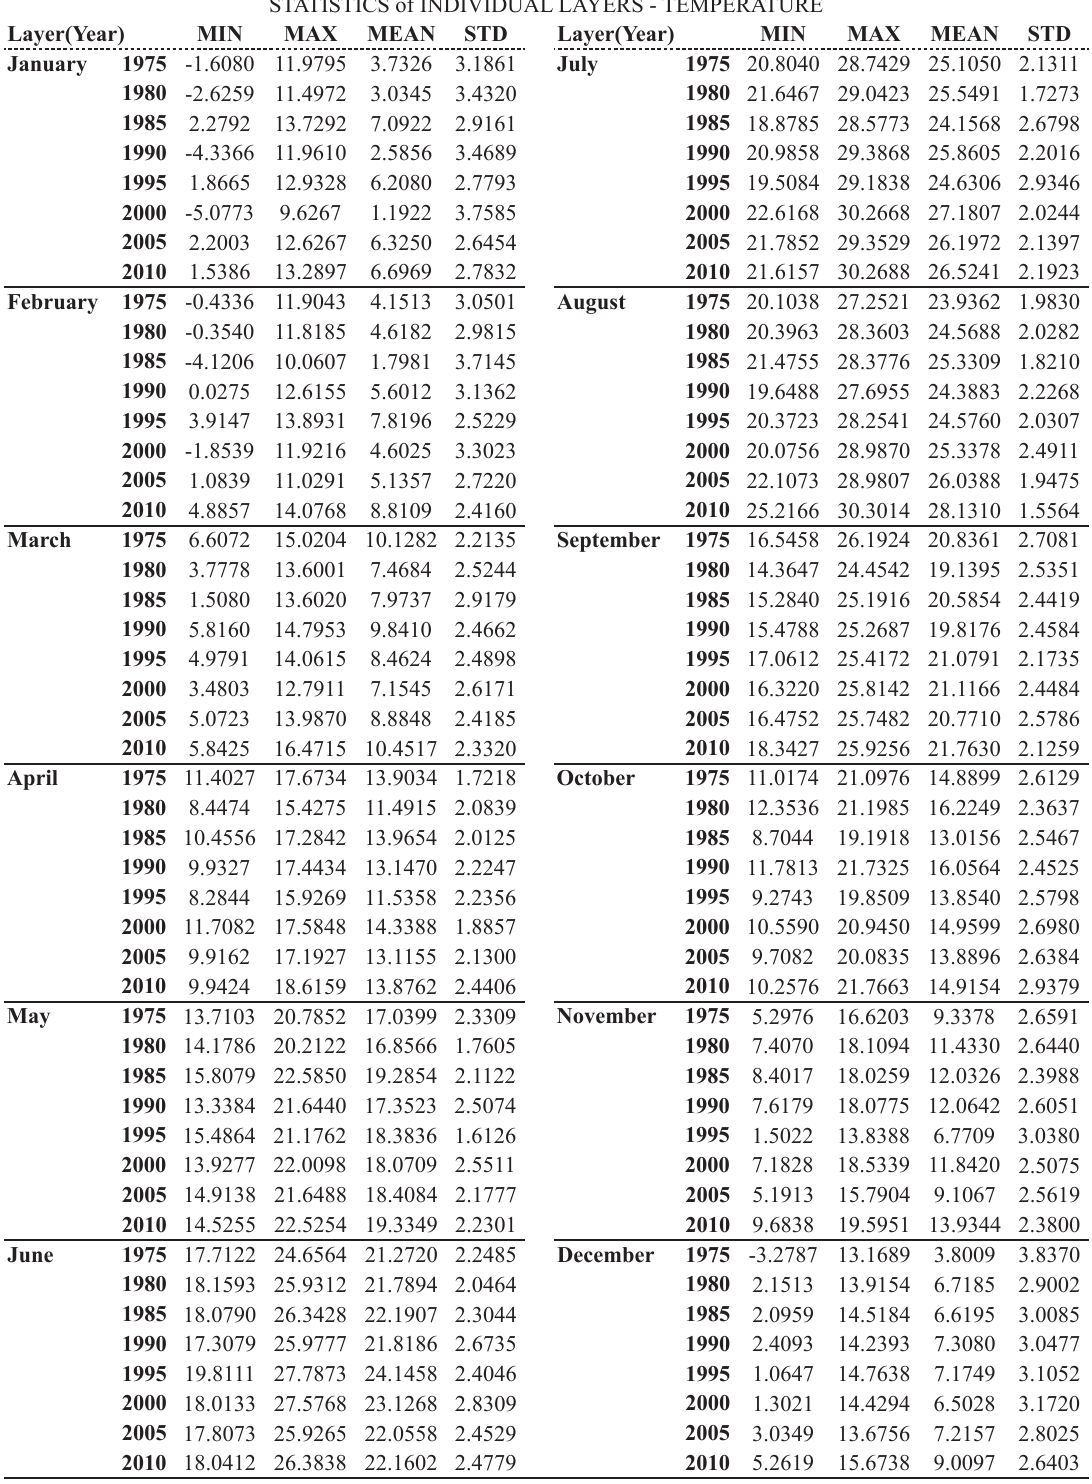
Main statistics for temperature layers (Minimum, Maximum, Mean, Standard